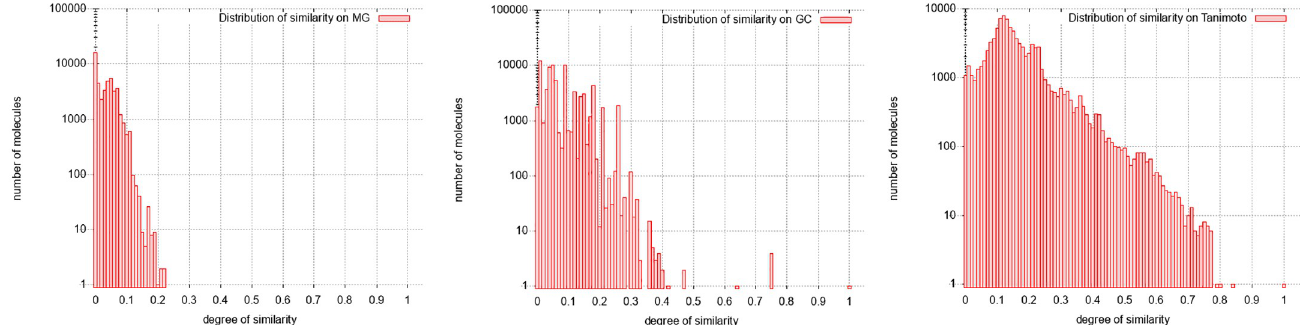
Fig 12. Distribution of similarity on Brevetoxine A. From left to right: Distribution with molecular graphs (MG), graphs of cycles (GC) and Tanimoto Coefficient (TC).